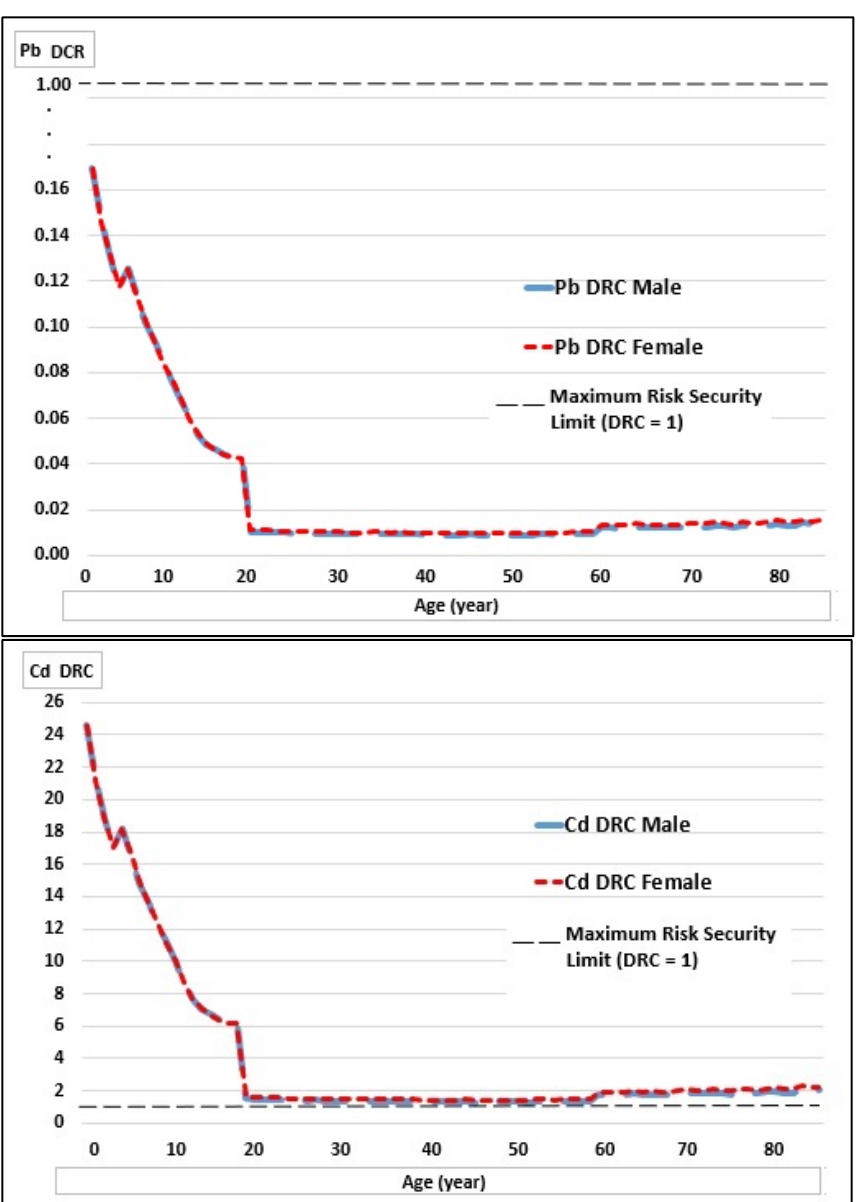
Figure 3. Dietary risk coefficient of Pb and Cd intake by age and sex in relation to the upper safe limit of risk. At the top is the Pb DRC, and at the bottom is the Cd DRC.